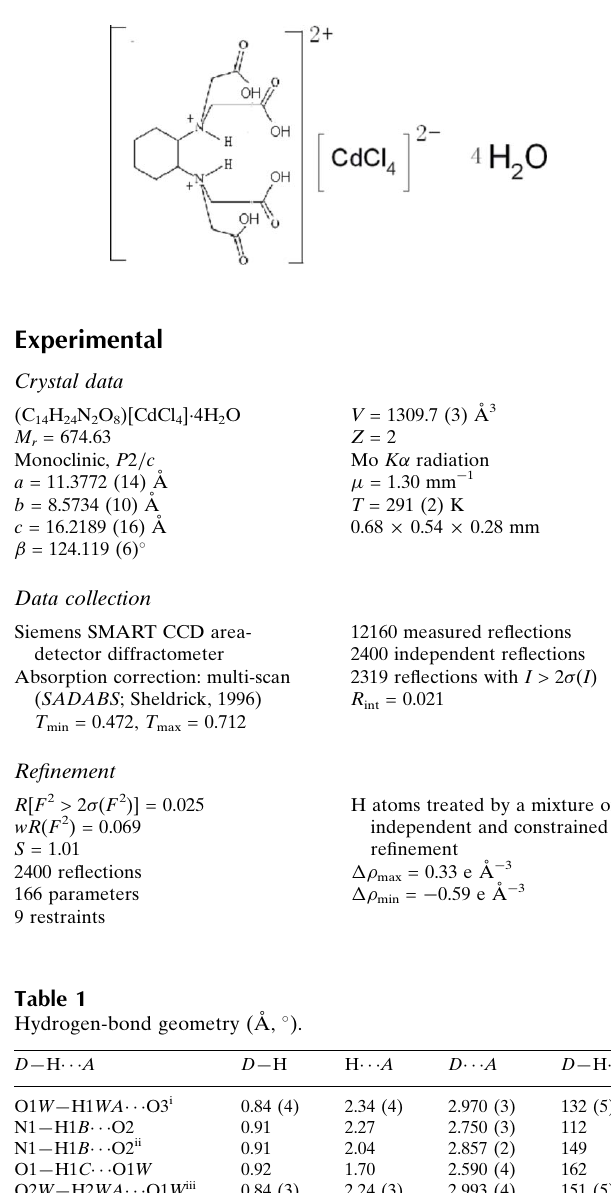
H atoms treated by a mixture of independent and constrained